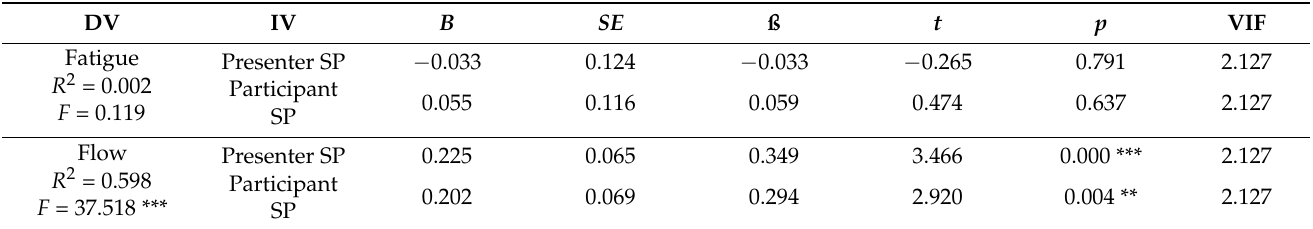
Table 9. Results of multiple regression using social presence to predict video conference fatigue and